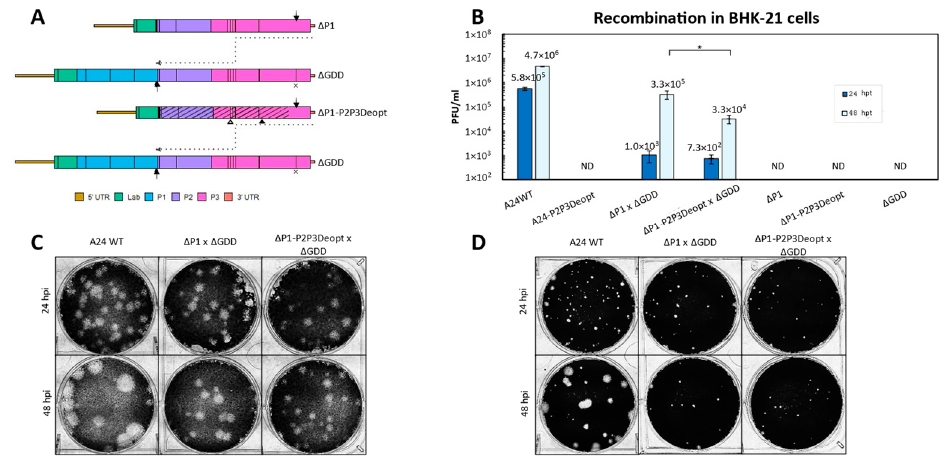
Figure 4. ( A ). Schematic model of FMDV recombination during negative-strand synthesis with the given templates. DIVA markers are indicated by open (3B1 deletion, RQKP9-12 → PVKV) and closed (3D H27N31 → YR) DIVA markers. Deoptimized regions are indicated by stripes. The Δ GDD within the active site of RdRp encoded by 3D is indicated by an X. Template switching must occur between the two arrows. ( B ). Number of infectious particles generated 24 and 48 h post-transfection in BHK-21 cells. * Statistically significant difference between the number of infectious virions produced from the different donor RNA templates. Error bars represent 1 standard deviation. ND—not detected. ( C , D ). Plaque morphologies of WT and recombinants in BHK-21 or LFBK- α V β 6 cells respectively, stained at 48 hpt.